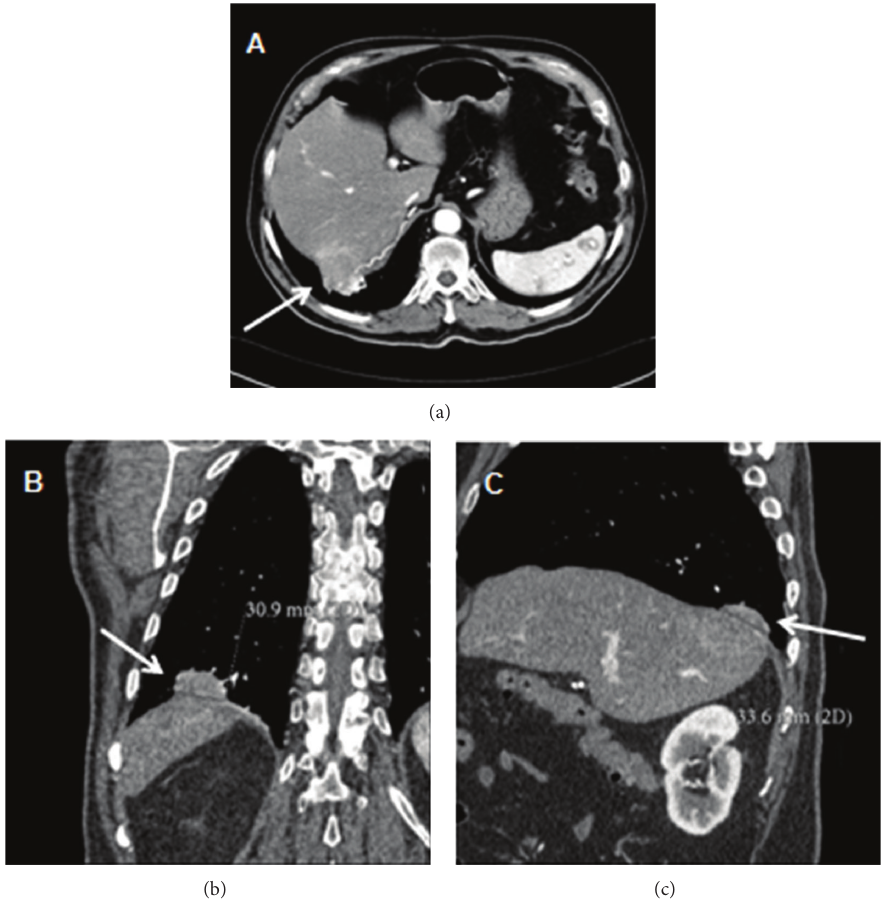
Figure 1: Axial (a), coronal (b), and sagittal (c) images from a computed tomography of neck, thorax, and abdomen with intravenous contrast demonstrating a nodular image close to the diaphragm, in the right side, with transdiaphragmatic infiltration, hepatic invasion, and arterial vascularization ( arrows ).